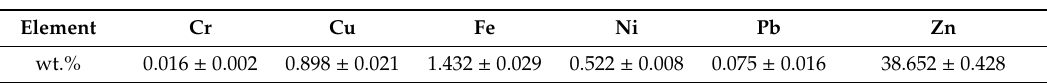
Table 3. Chemical composition of important base metals in EAF dust (after aqua regia digestion and AAS / ICP-OES